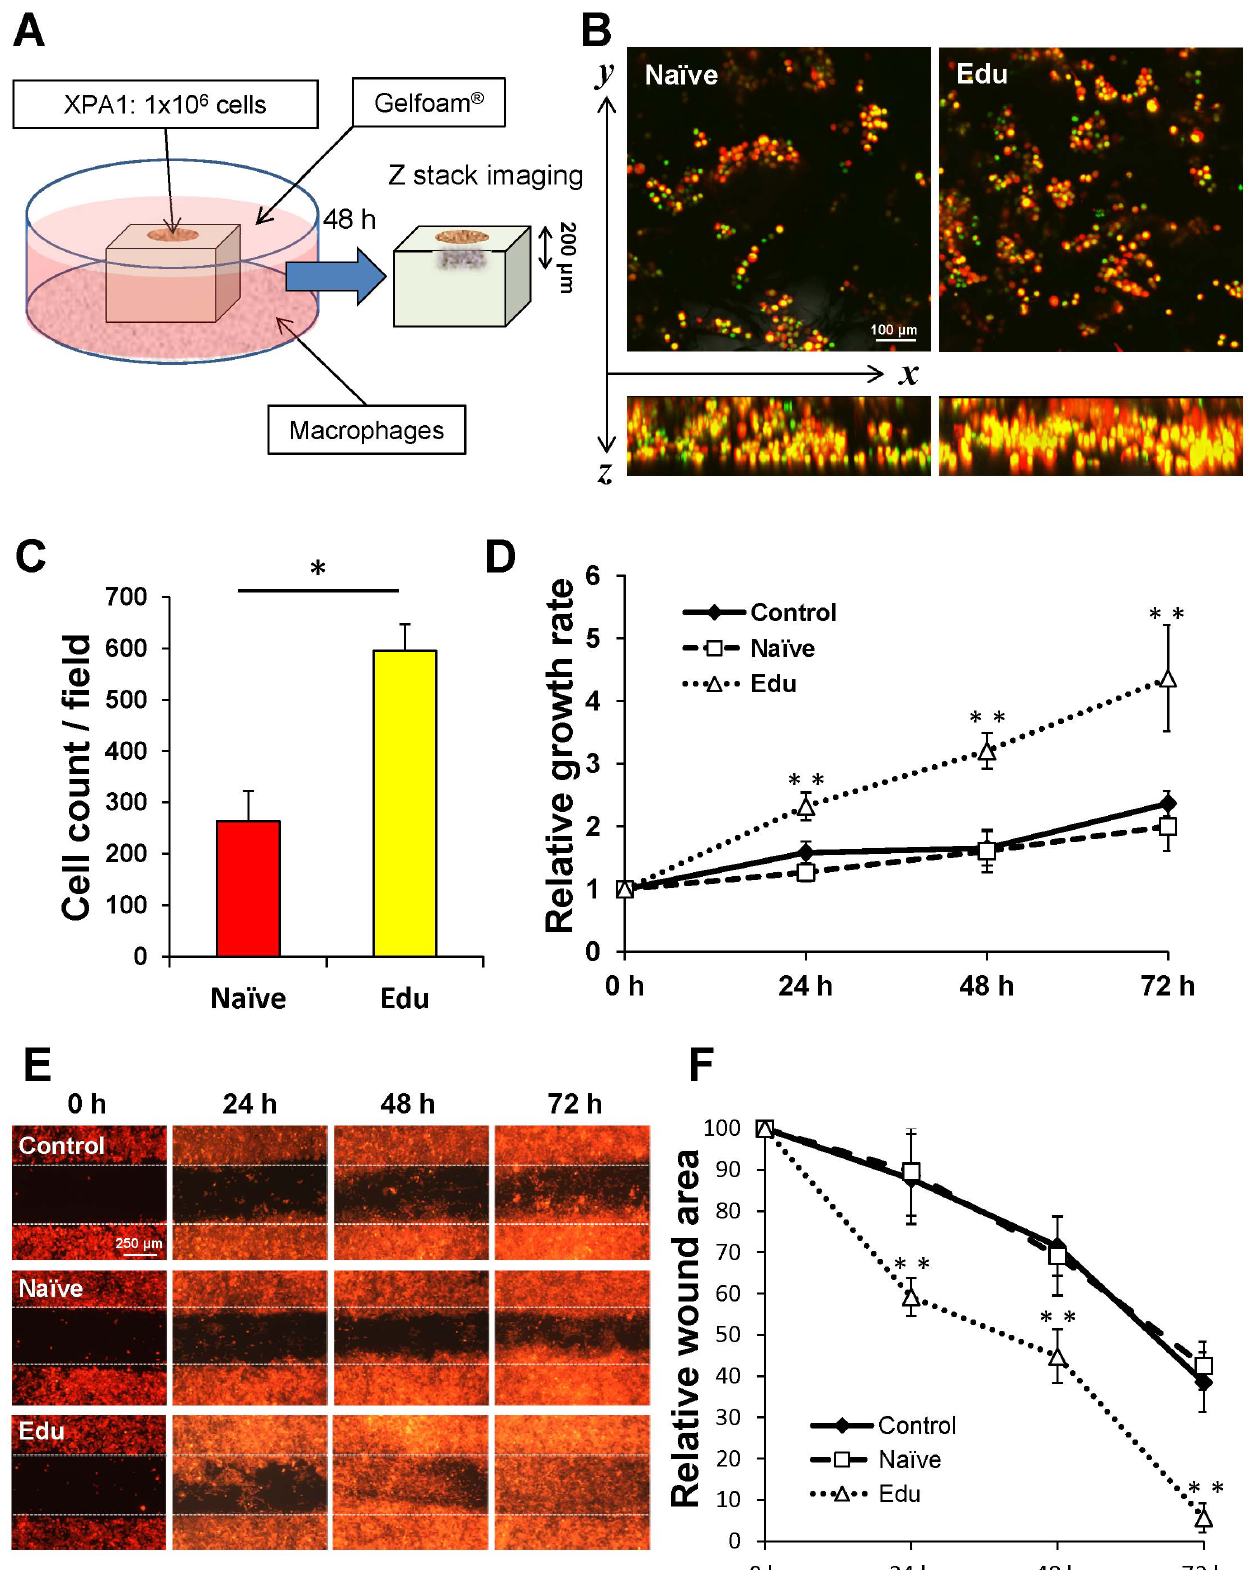
Figure 2. Conditioned medium from Edu-macrophages promotes pancreatic cancer cell proliferation and migration. ( A ) A schema of the separated co-culture system using Gelfoam. Naı¨ve- or Edu-macrophages were co-cultured with dual-color XPA1 GFP-RFP cancer cells, but they were separated from each other by Gelfoam. Forty-eight hours later, images were obtained from the surface to 200 m m depth, every 1 m m, and